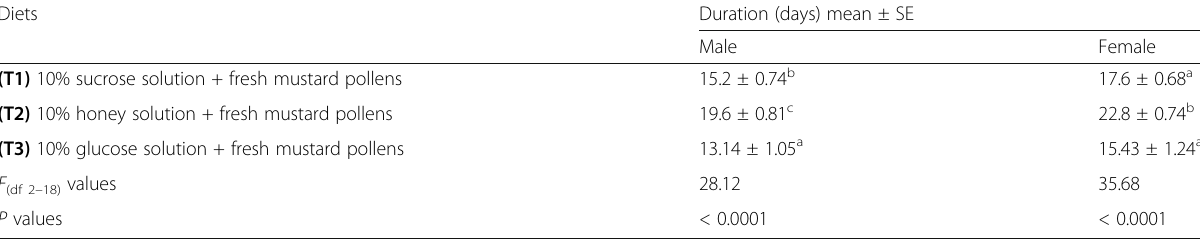
Table 2 Longevity of Eupeodes frequens on different diets